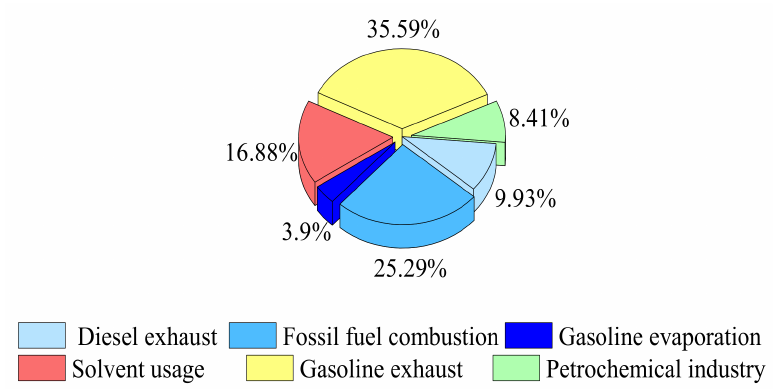
Figure 4. The proportion of each source during the whole observation